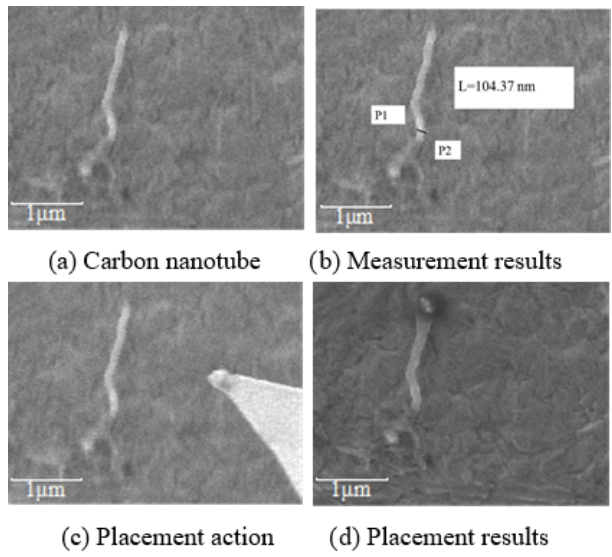
Figure 12. Nanocluster particles picked up on ITO glass substrate.